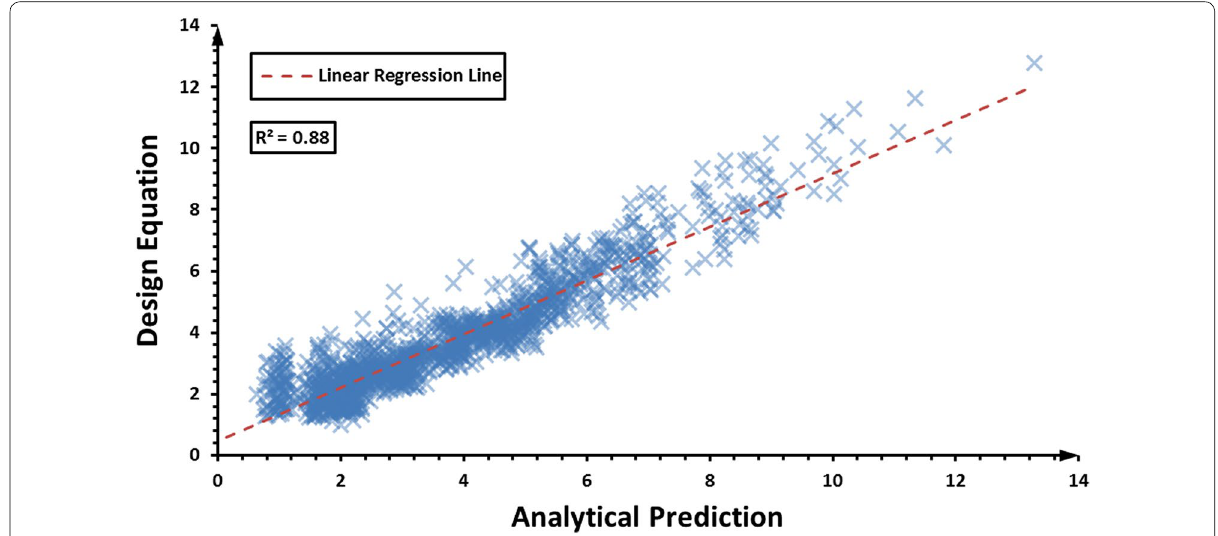
Fig. 9 Comparison of analytical and regression